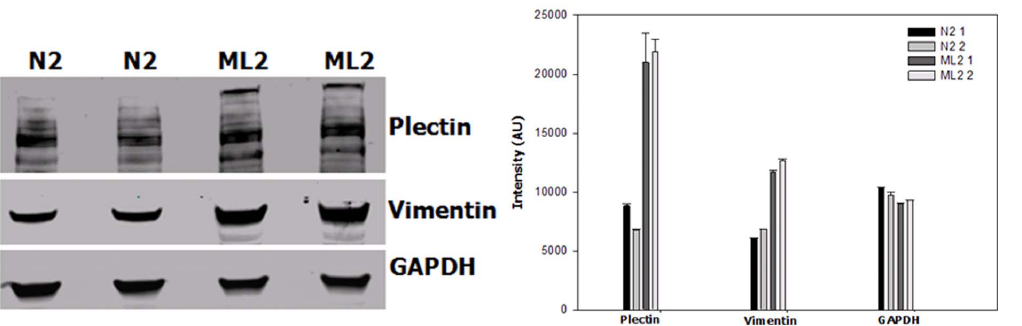
Figure 2. Validation of differentially upregulation of plectin and vimentin in PC3-ML2 cells. Total cell lysates (40 m g) of N2 and ML2 cells were subjected to SDS-PAGE. The separated proteins were analyzed by Western blot analysis to detect plectin and vimentin as described. GAPDH